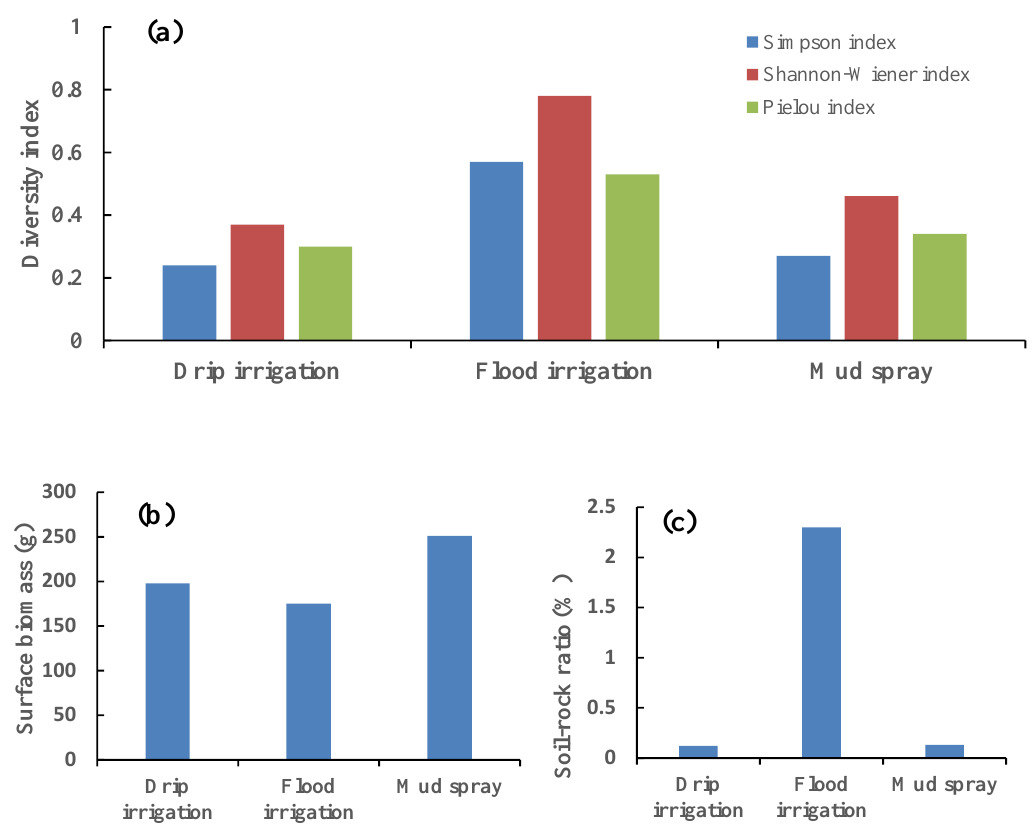
Figure 6. Effect of water replenishment measures on surface vegetation and soil restoration. Note: ( a – c ) are subtitle of Figure. ( a ) is diversity index, ( b ) is surface biomass and ( c ) is soil-rock ratio.